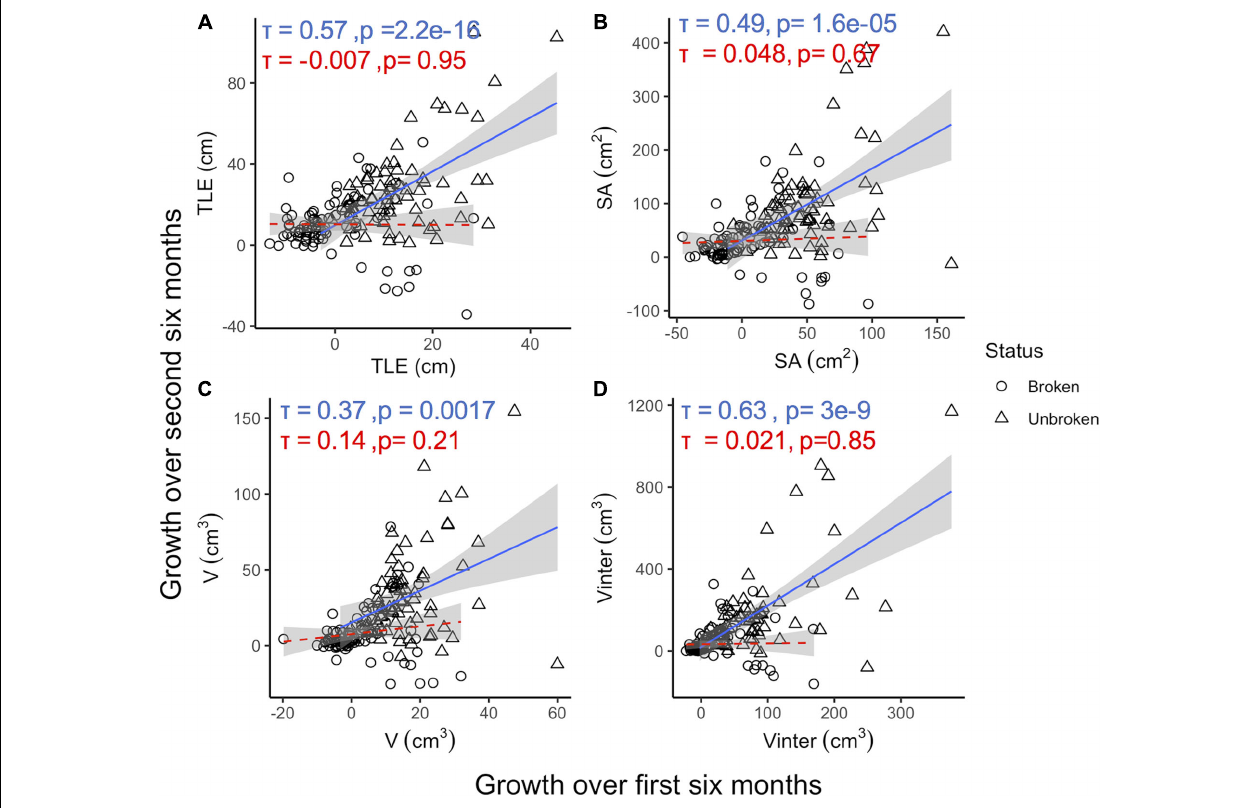
FIGURE 4 | Growth over the first 6 months compared to growth over the second 6 months for TLE (A) , SA (B) , V (C) , and V inter (D) colored by whether coral experienced breakage (open circles, dashed red line) or not (open triangles, solid blue line). Kendall’s tau coefficients and p -values are included for correlations. Shaded areas around each line represent the 95% confidence intervals ( n =